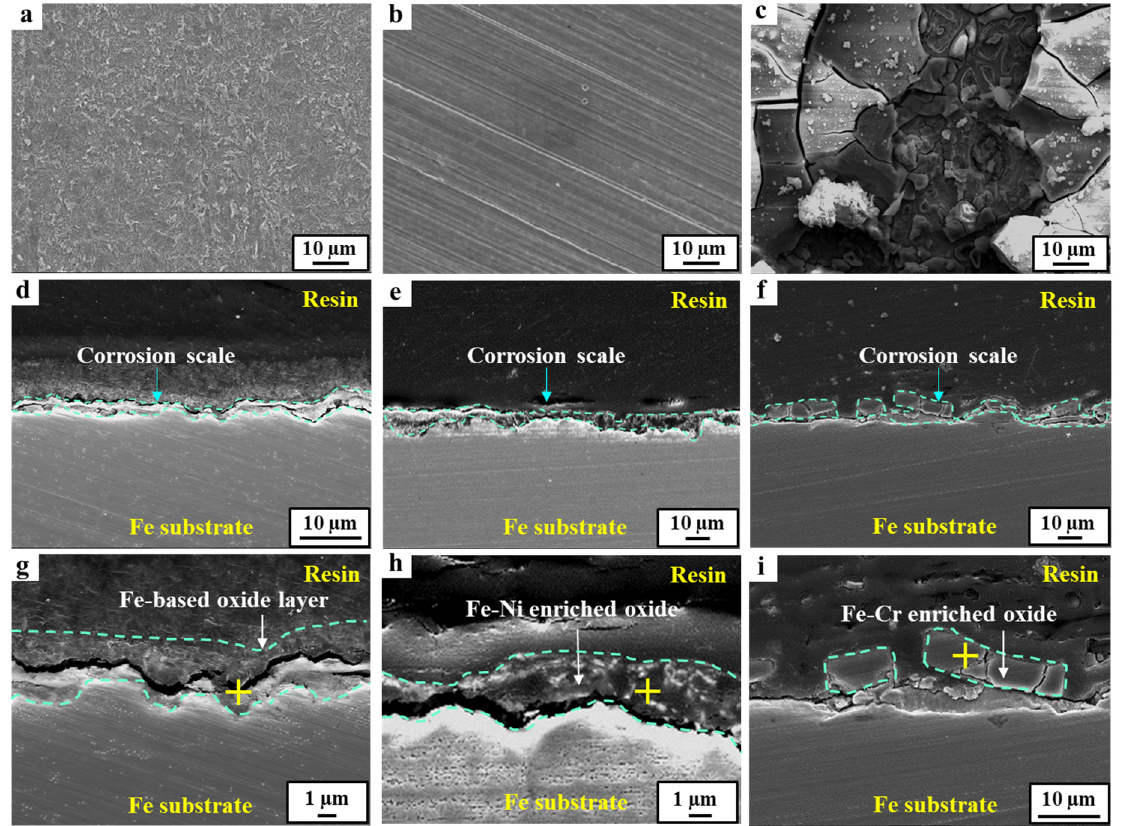
Figure 5. FE-SEM images of the tested samples immersed in an acidic solution for seven days. ( a – c ) Surface images of APIX70, 9Ni, and 24Mn3Cr, respectively; ( d – f ) Cross-sectional images of APIX70, 9Ni, and 24Mn3Cr, respectively; ( g – i ) Magnified view of ( d – f ). Table 4. EDS quantitative analysis at each point marked on Figure 5.